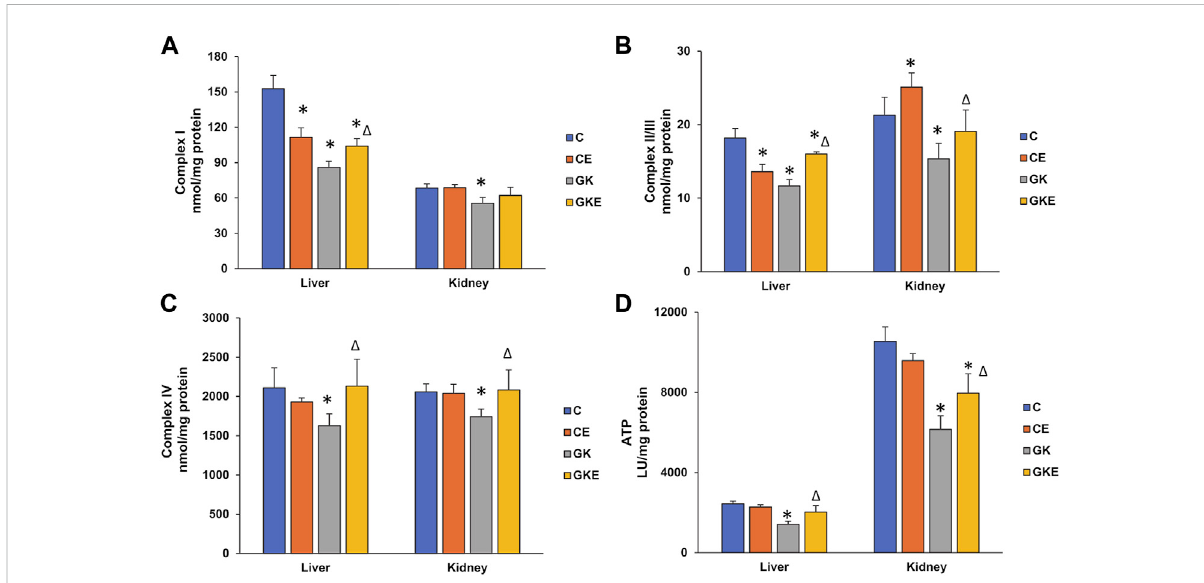
FIGURE 5 Exercise-induced alterations in mitochondrial bioenergetics. Activities of mitochondrial respiratory complexes from freshly isolated mitochondria were measured in the liver and kidney of control Wistar (C) and diabetic GK (GK) and exercise-trained control (CE) and GK (GKE) rats ( n = 5). Activities of Complex I (A) , Complex II/III (B) , and Complex IV (C) were measured by the methods of Birch-Machin and Turnbull using coenzyme Q2, succinate, and reduced cytochrome c as substrates as described in the Materials and Methods. The total ATP levels (D) were measured using the ATP somatic cell assay kit (Sigma-Aldrich Fine Chemicals, St Louis, MO, United States) and the luminescence was read immediately using theTD-20/20 luminometer. Histogram values are mean ± of three independentexperiments and statistical signi fi cance is shown as asterisks, which was fi xed as p < 0.05 (* indicates statistical signi fi cance compared with control Wistar rat tissues while Δ indicates statistical signi fi cance compared with diabetic GK rat